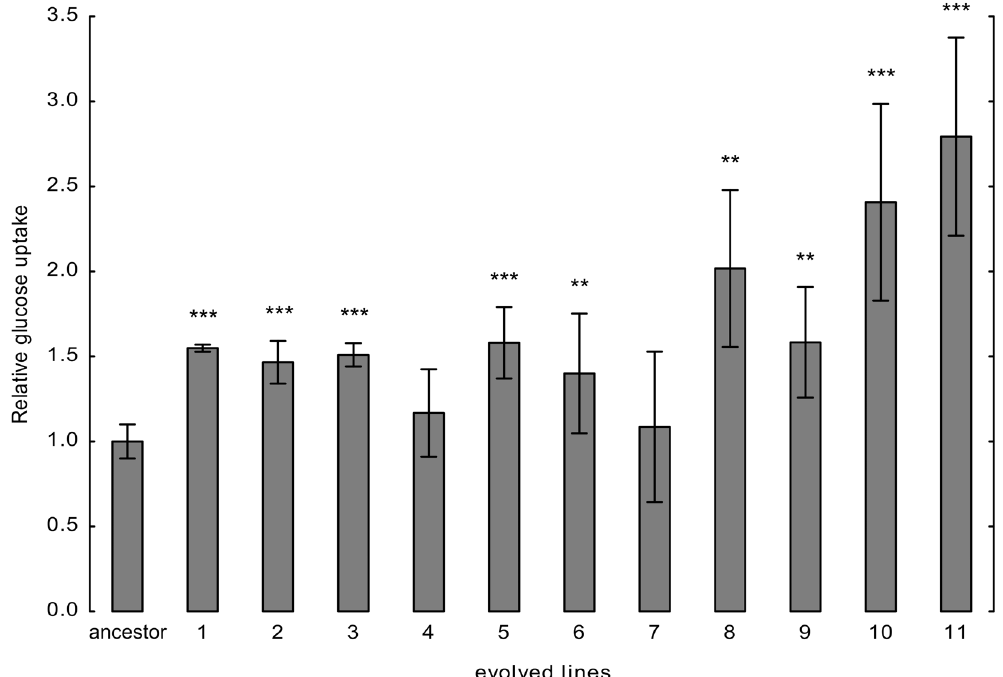
Fig 7. Glucose uptake in the ancestor and the evolved lines. After 15 h of growth, optical densities and medium glucose content were measured in parallel in the ancestor and the evolved lines. Glucose uptake rates were estimated by the drop of glucose content per cell. Glucose uptake rate per cell was normalized to that of the ancestor value. The bars indicate mean ± 95% confidence interval. Two-sample t test was used to assess difference in glucose uptake between the ancestor and the evolved lines. * / ** / *** indicates p -value < 0.05/0.01/0.001, respectively. To ensure that changes in glucose uptake reflect the impact of the accumulated mutations in the evolved lines (rather than the direct effects of mistranslation), tRNA CAGSer was swapped for the corresponding empty vector in the ancestor and the evolved lines.